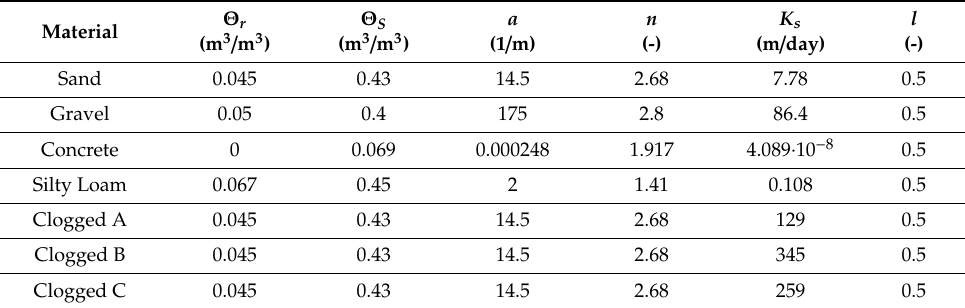
Table 1. Filtration properties of used soils.